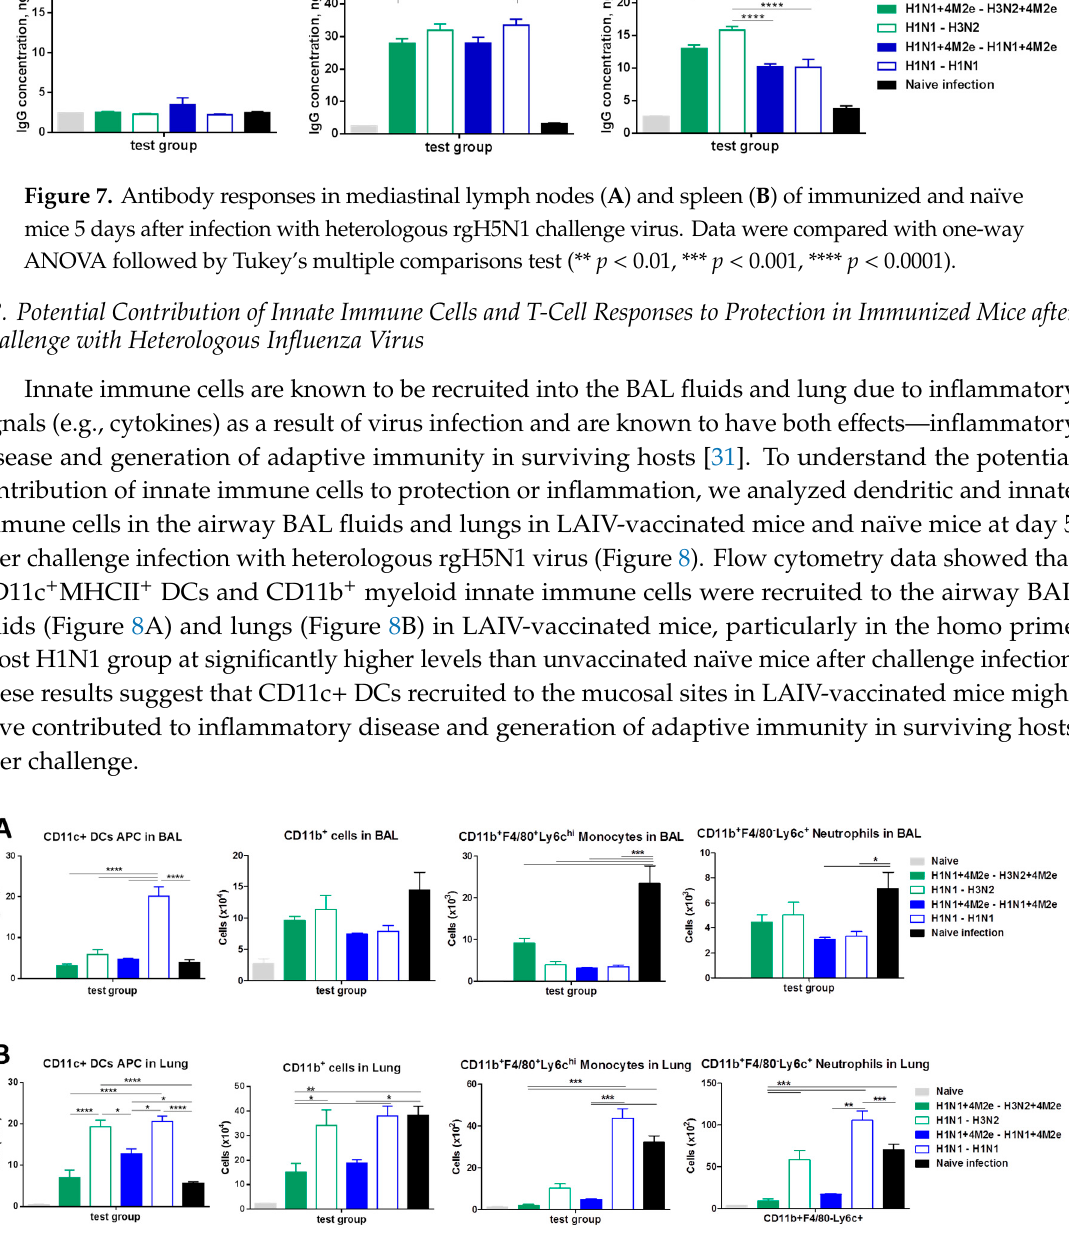
Figure 8. Dendritic and innate immune cells in the airway bronchoalveolar lavage (BAL) fluids ( A ) and lungs ( B ) in LAIV-vaccinated mice and naïve mice at day 5 after infection with heterologous challenge virus. Data were compared with one-way ANOVA followed by Tukey’s multiple comparisons test (* p < 0.05, ** p < 0.01, *** p < 0.001, **** p < 0.0001).